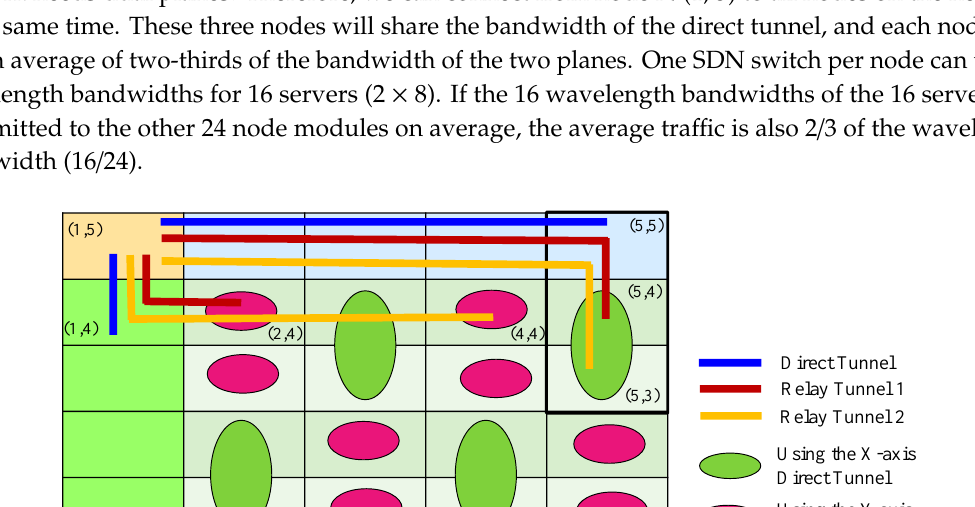
Figure 10. Tunnel assignment of a two-plane optical tunnel switching network with 25 nodes.